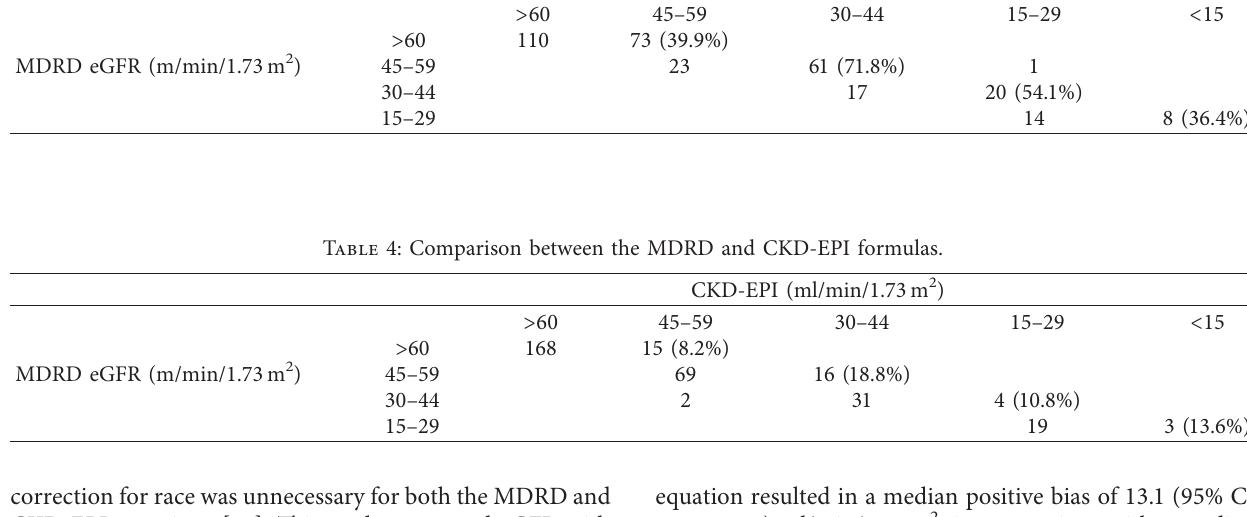
race removed formulas.